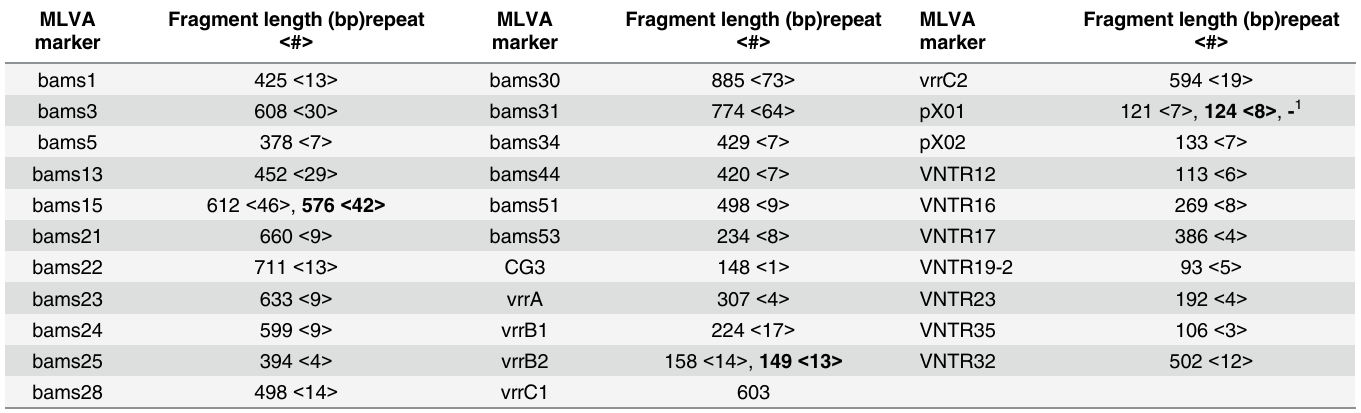
Table 4. Multiple 31-Loci VNTR of B . anthracis isolates from Pollino. The predominant alleles of fragment length analysis for 31 markers of MLVA in 114 randomly chosen isolates are shown. Variations in these markers found in some isolates are shown in boldface (32 markers are shown since VNTR32 and bams1 represent the same VNTR